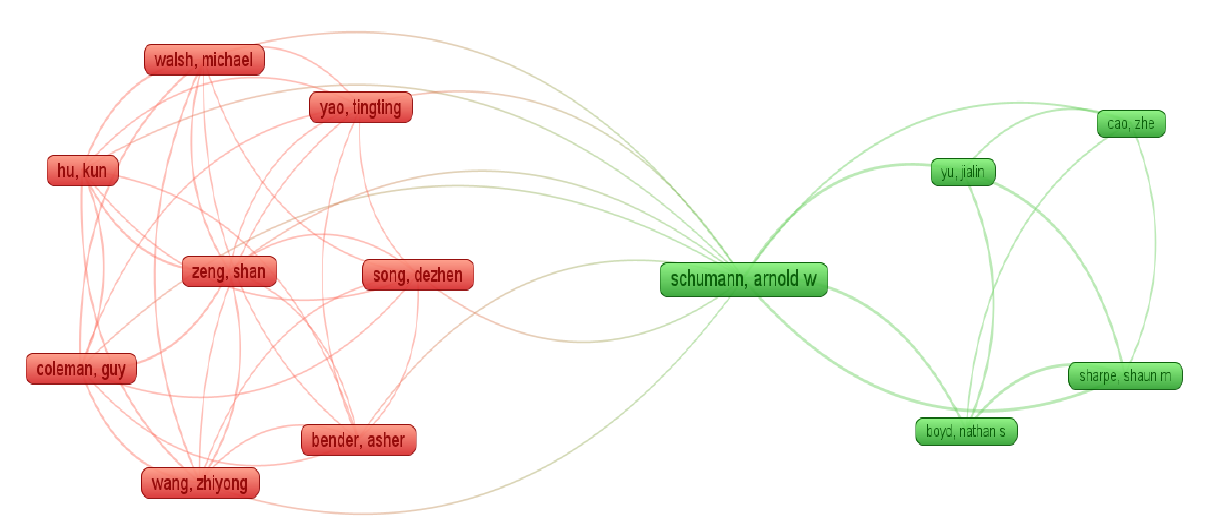
Figure 11. Co-Author Citation Graph. Table 1. Breakdown of frequency of articles filtered with respect to title, abstract, and content across search queries Q1. Q2 and Q3 and digital